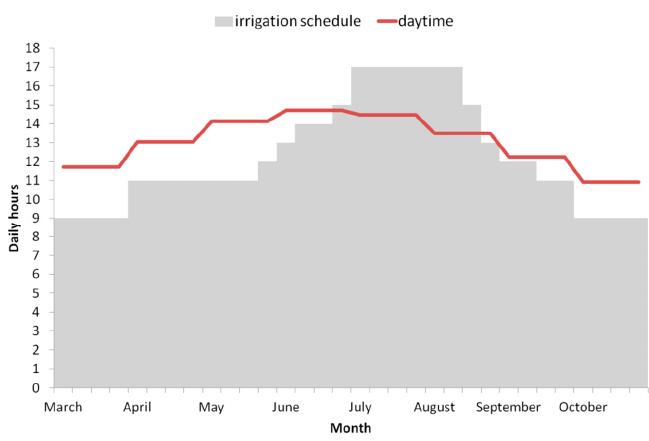
Figure 2. Hours per day of irrigation scheduling and daytime.